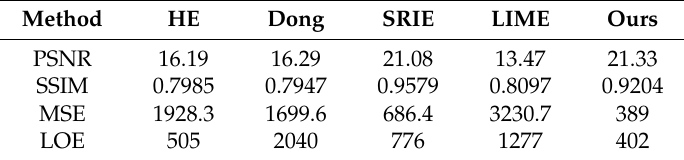
Table 2. Objective evaluation of different algorithms for synthetic low-light images.